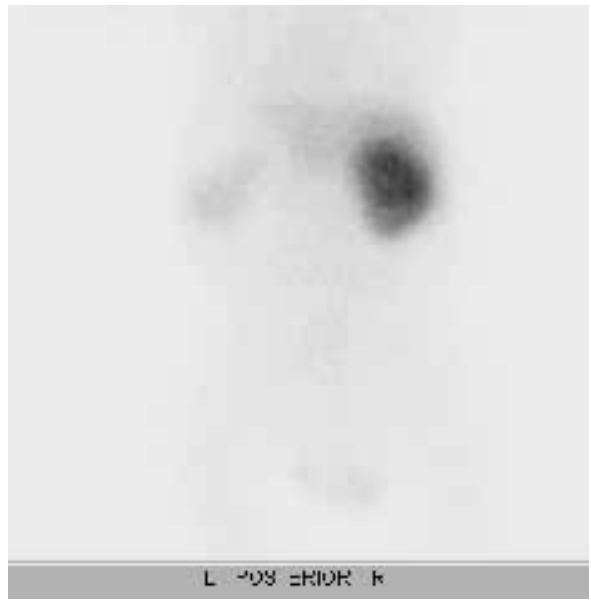
FIGURE 7B . Renal scan demonstrating the absence of function in a MCDK.